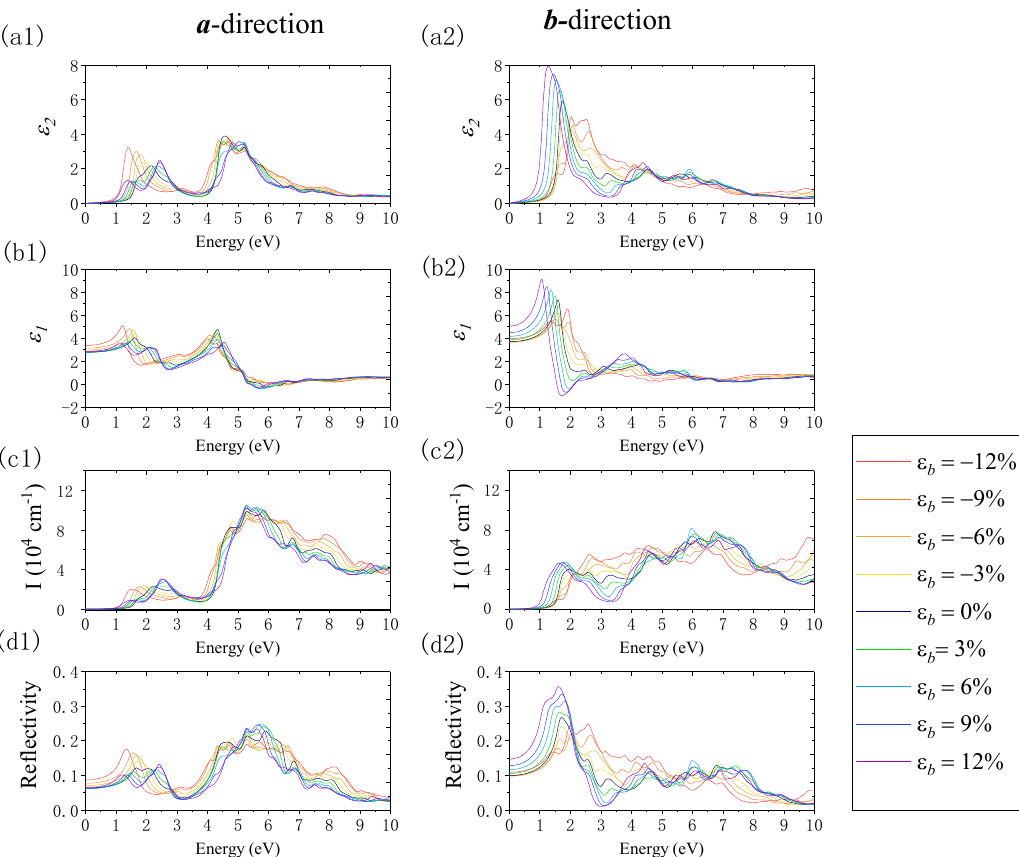
Figure 12. The changes in the imaginary part of the dielectric function ( ε 2 ), real part of the dielectric function ( ε 1 ), absorption coefficient (I), and reflection coefficient (R) when applying uniaxial strain along b -direction using the PBE method. Panels ( a1 – d1 ) and ( a2 – d2 ) show the results along the a - and b -directions, respectively.